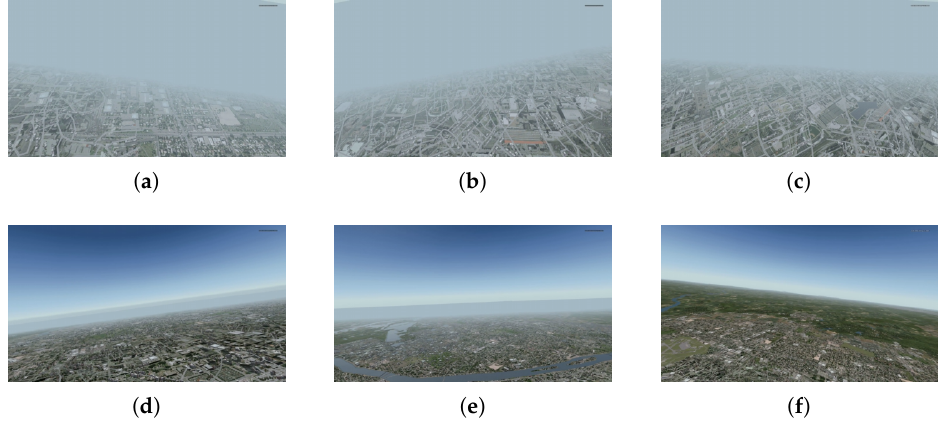
Figure 16. Selected frames from last phase of spin recovery for test videos in group 4: ( a ) 0.3 NM, ( b ) 0.4 NM, ( c ) 0.5 NM, ( d ) 3–5 NM, ( e ) 5–10 NM, ( f ) >10